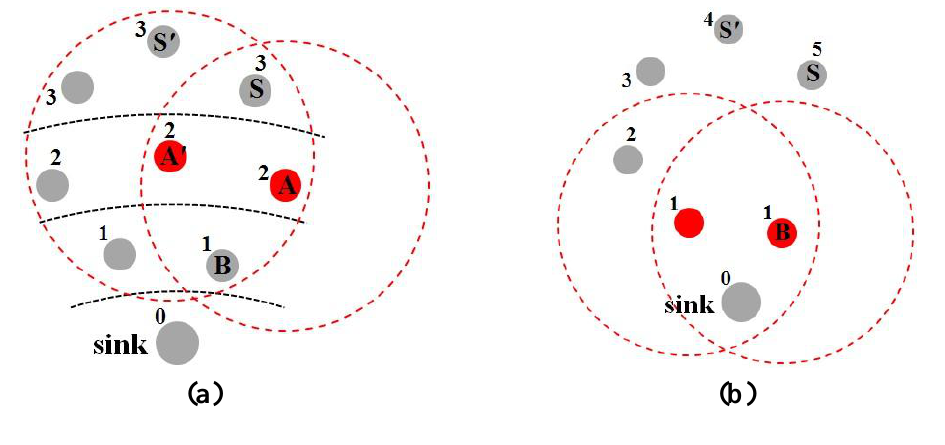
Figure 1. (a) After grade division, the network is divided into several annular grades similar to concentric circles centered at the sink; (b) if A′ and A do not exist, S′ and S are in grade 4 and 5,